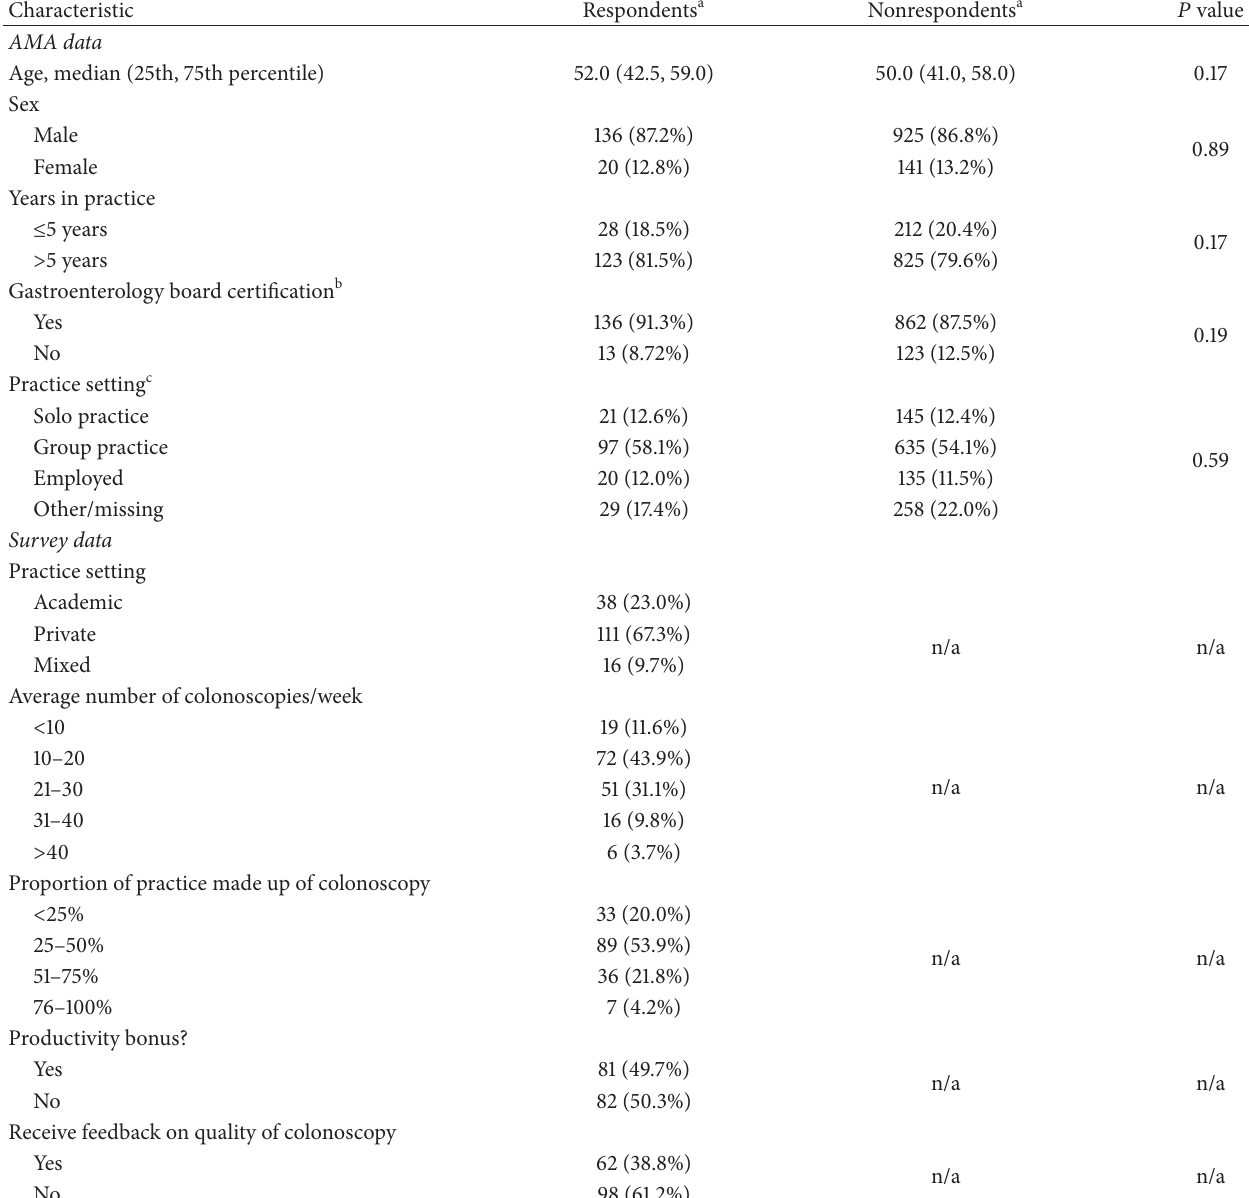
Table 1: Characteristics of physician respondents &